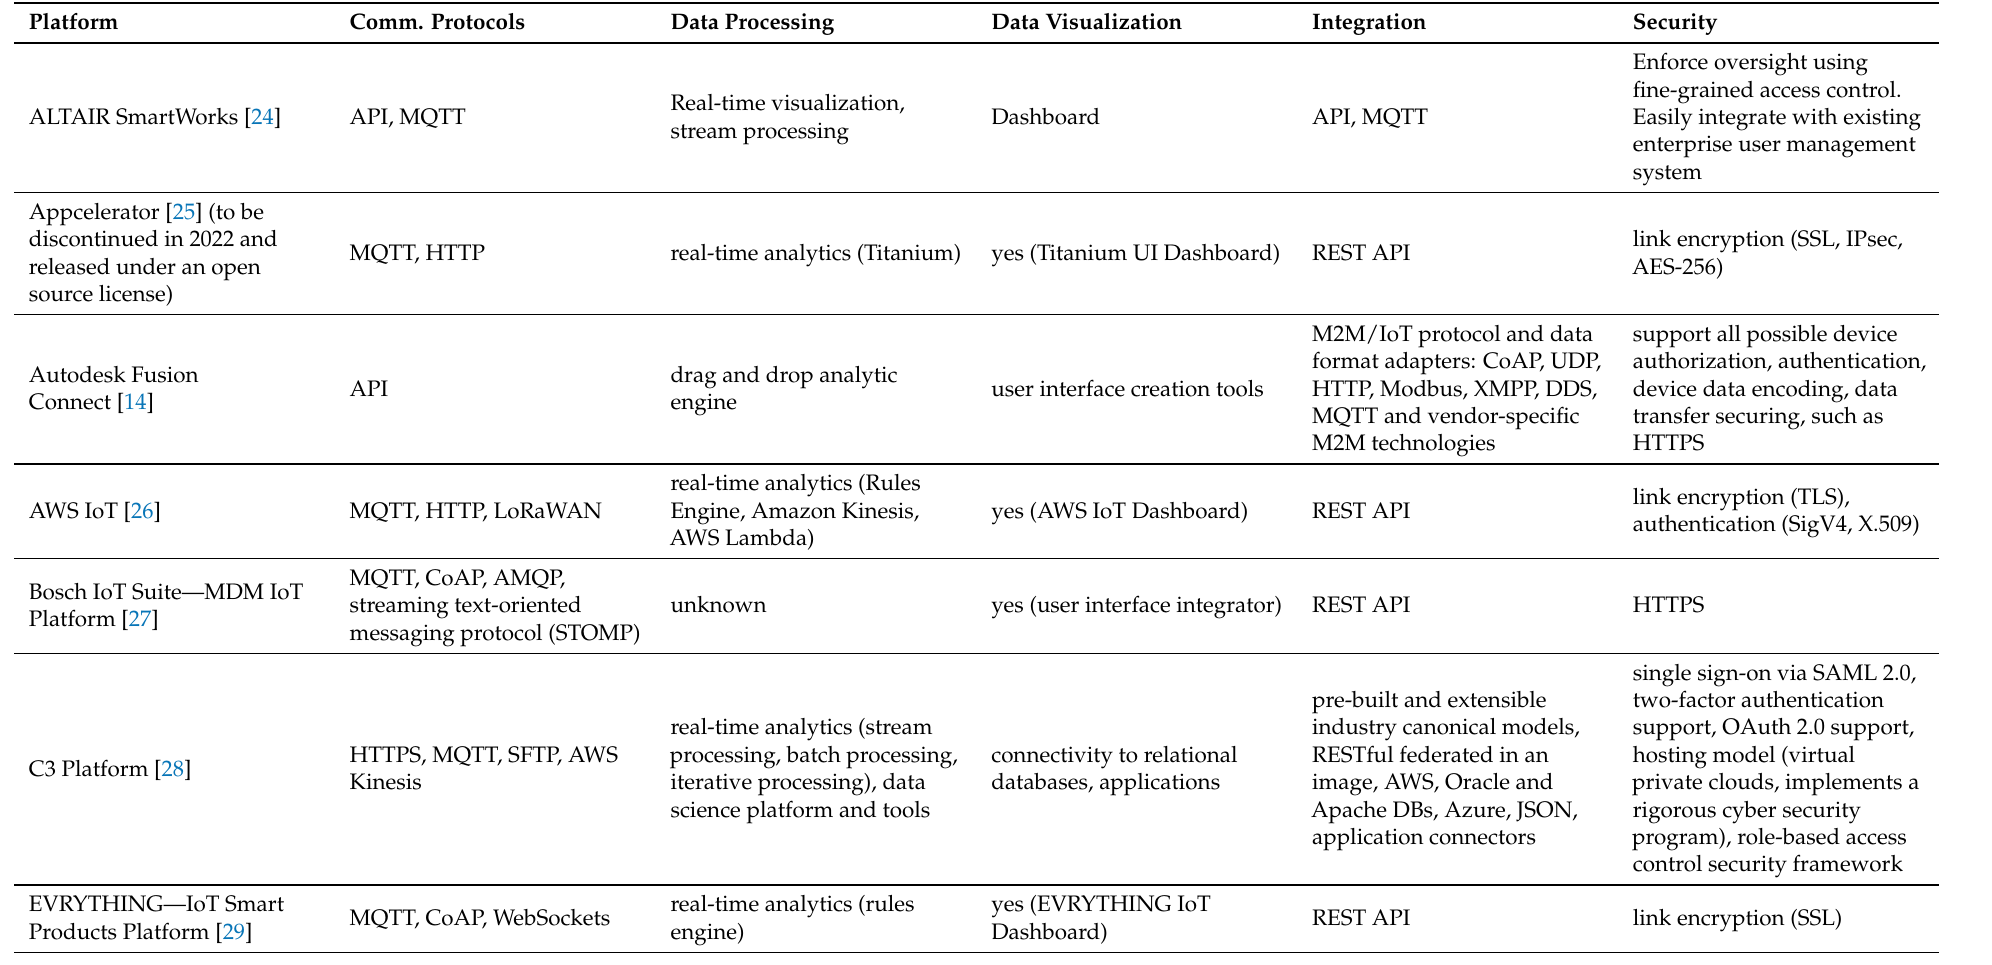
Table 1. Comparison of closed source